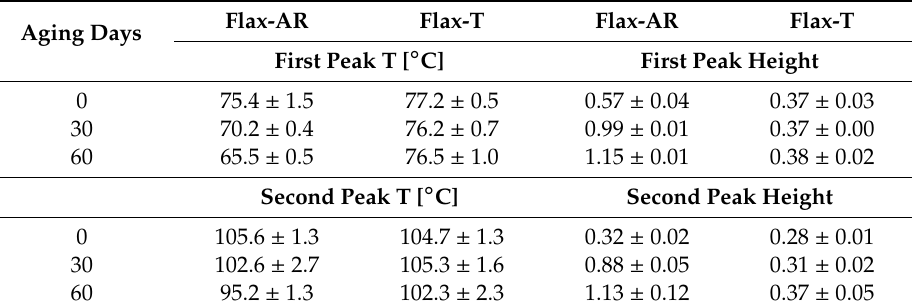
Table 2. Damping properties of flax composites for each aging